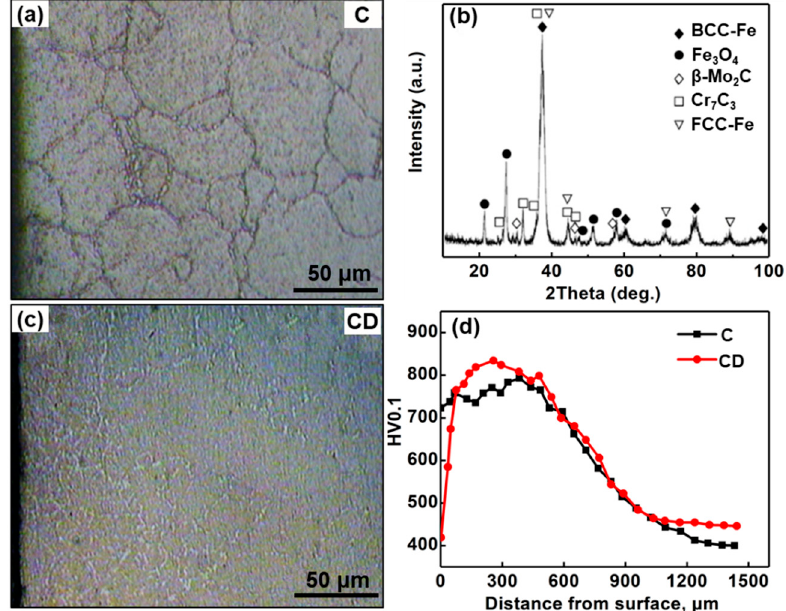
Figure 2. ( a ) Optical micrograph of cross-sectional microstructure of the carburized layer of Sample C; ( b ) XRD pattern of Sample C surface; ( c ) Optical micrograph of cross-sectional microstructure of the carburized layer of Sample CD; ( d ) Microhardness profiles along the modified layers of Sample C and Sample CD.